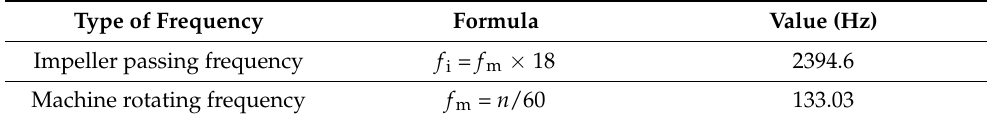
Table 6. Summary of compressor dominant